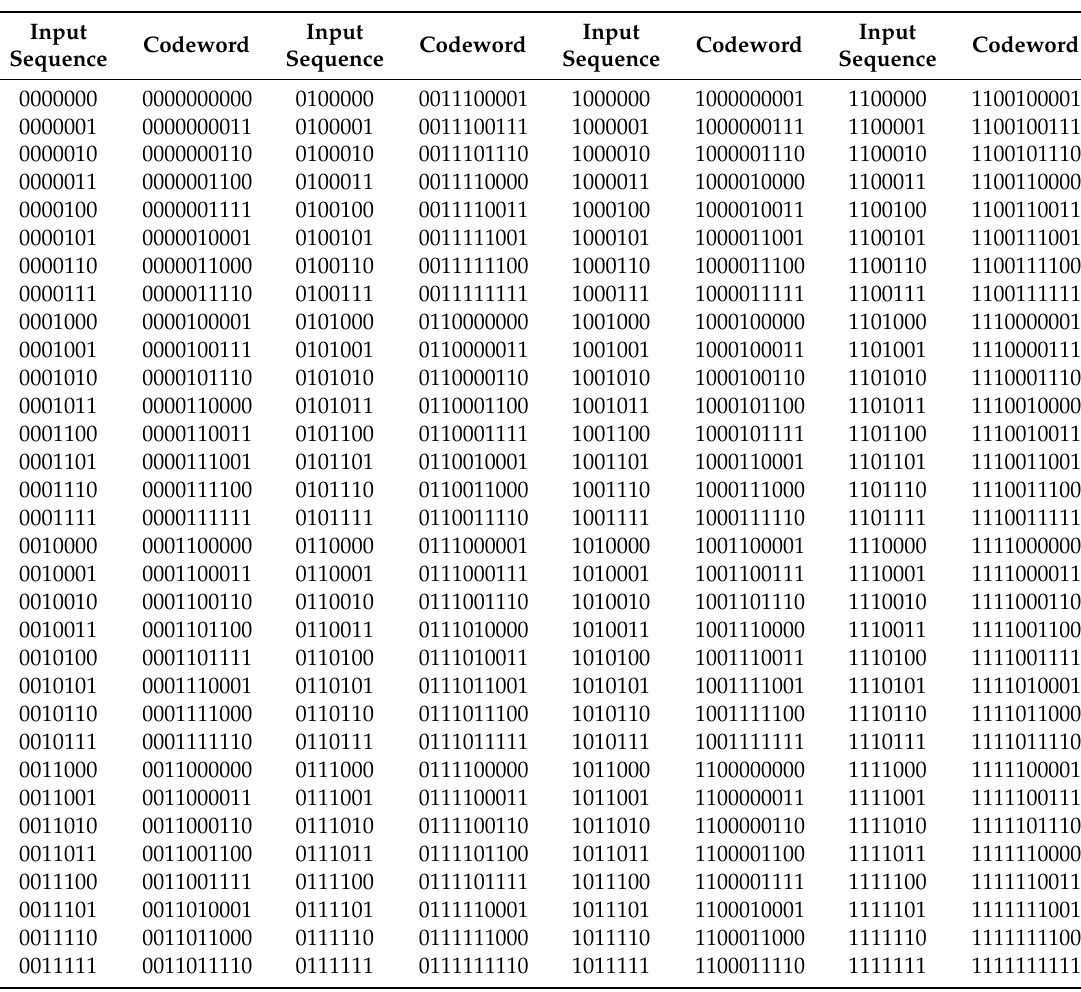
Figure 4. Available patterns for each column of codeword. Table 1. Codeword list of the proposed 7 / 10 modulation